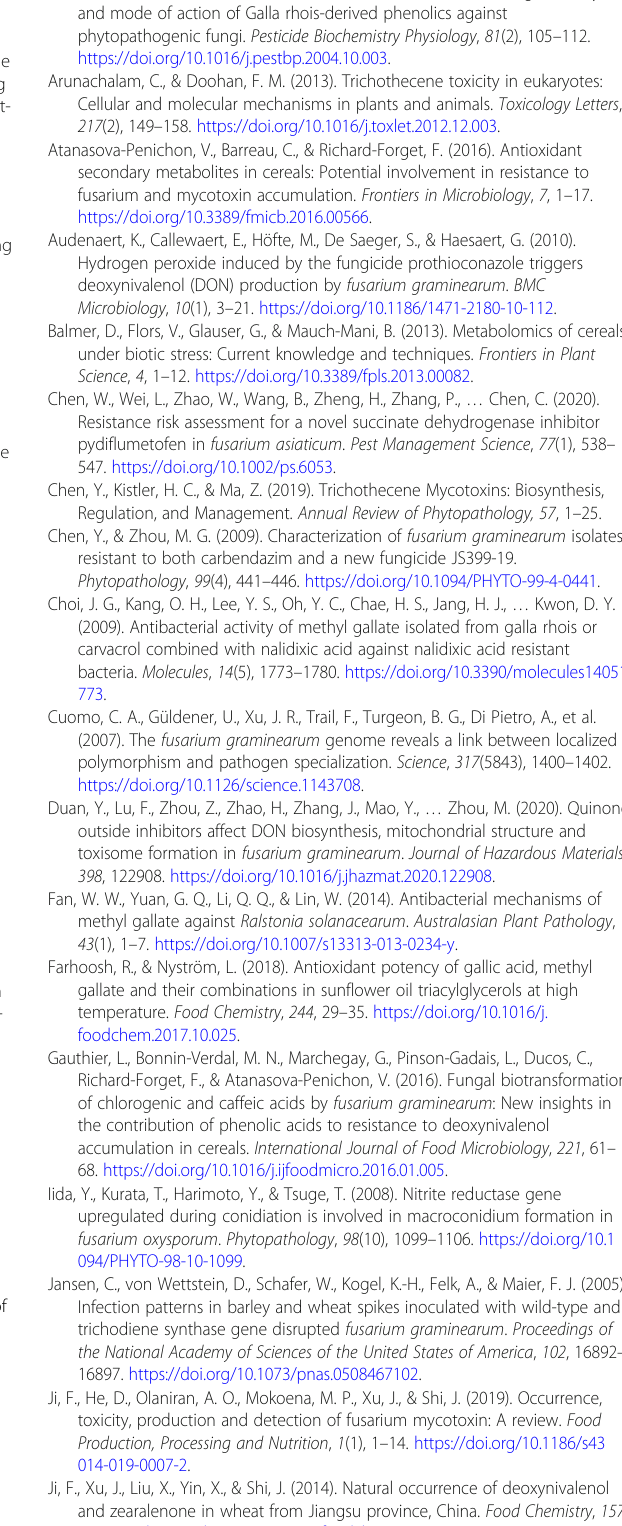
graminearum . Table S4. KEEG analysis of the DGEs responsive to 0.5% (w/v) MG treatment in F. graminearum